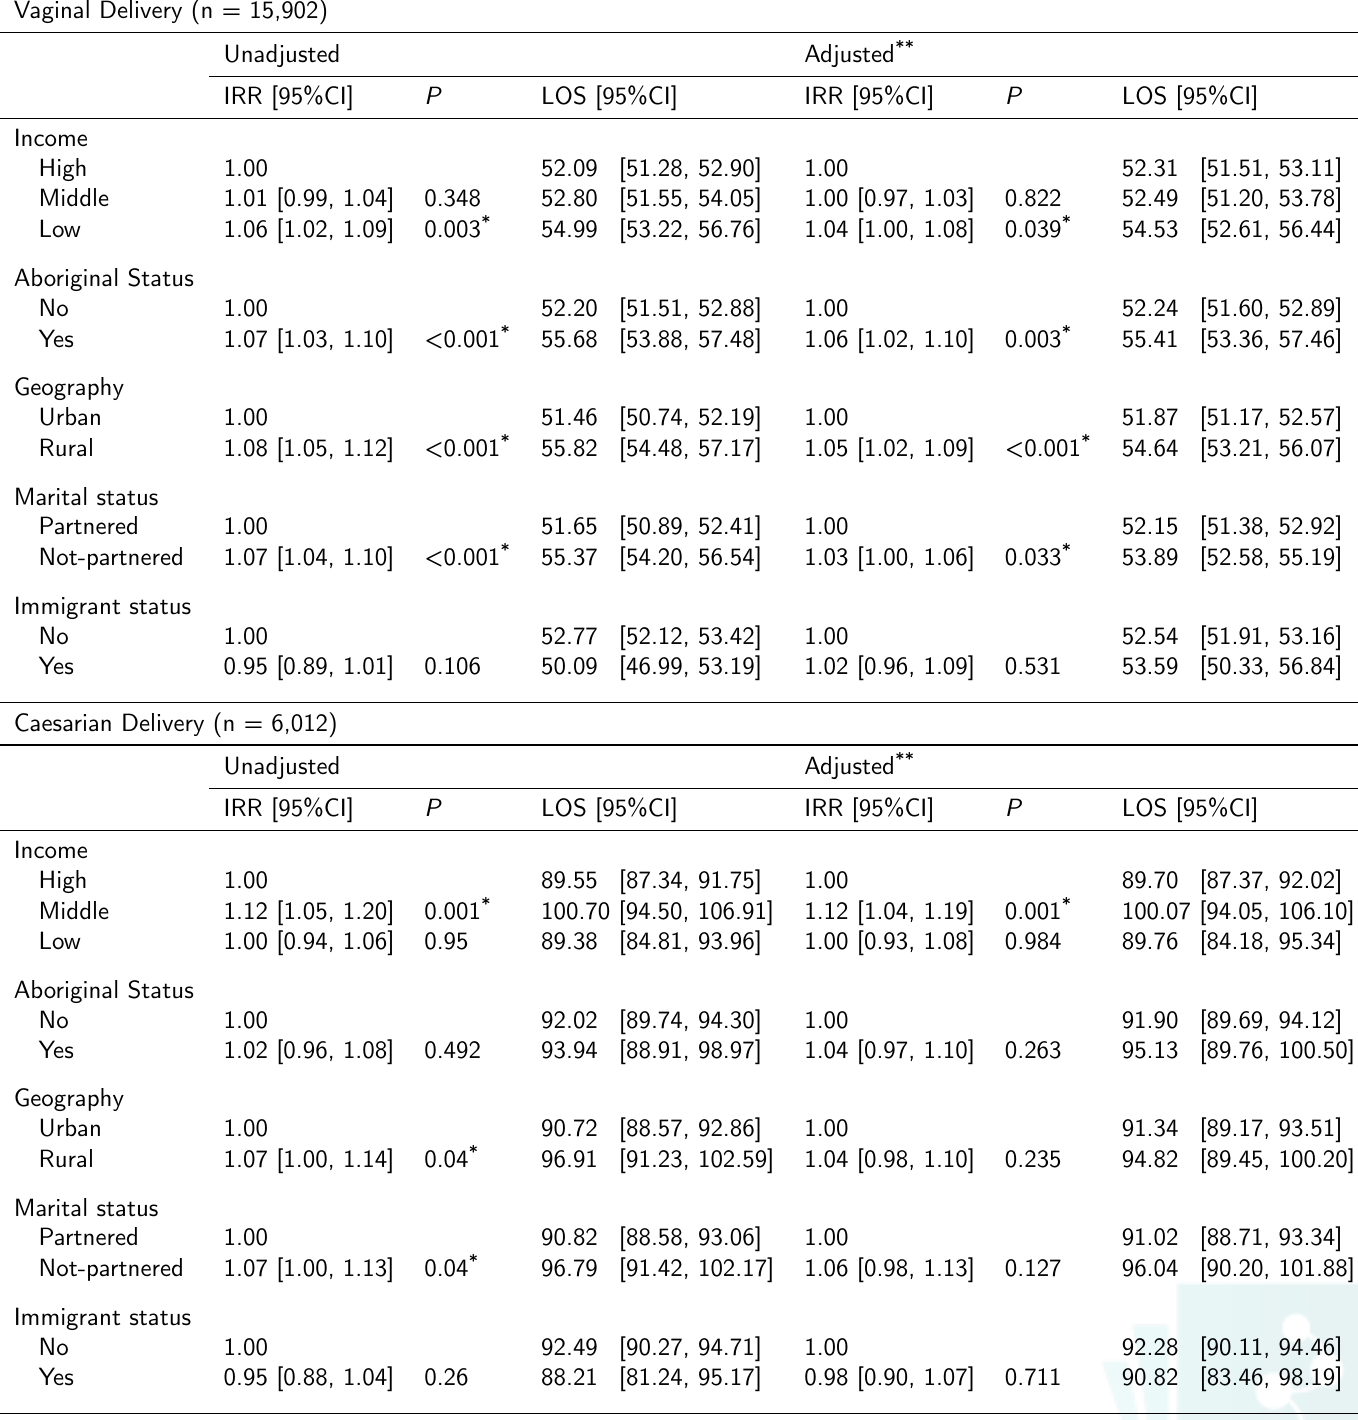
Table 3: Incidence rate ratios and marginal estimates of length of stay (LOS) in